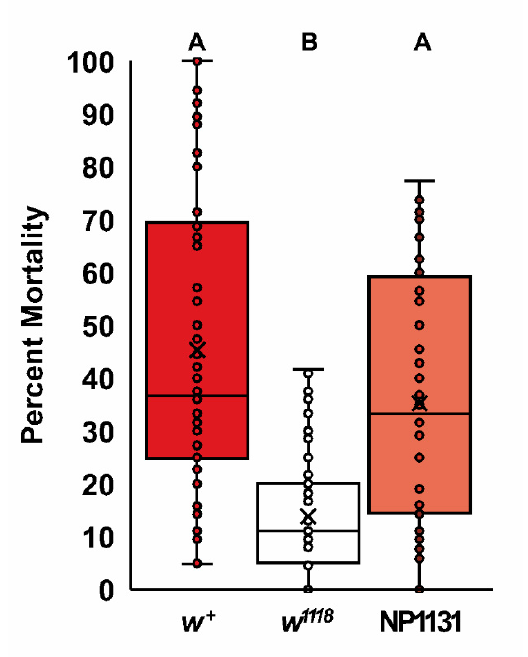
Figure 5. The w 1118 mutants have increased freeze tolerance. Wildtype Canton-S ( w + ), w 1118 , and w 1118 ; NP1131(mini- white ) genotypes were subjected to 120 min at − 5 °C, followed by a 24 h recovery at 25 °C. The median percentage of mortality after this recover period is shown as the center line, with the mean indicated by the x. There were significant differences in mortality between genotypes (Kruskal–Wallis, k = 73.404, p < 0.0001, n = 64–68). The w 1118 flies survived the subfreezing temperature significantly better than w + and w 1118 ; NP1131 (Dunn’s procedure, p < 0.0001; n = 64–68). Groups that do not share letters above the box plots are significantly different from each other according to the Dunn’s post hoc test ( p < 0.05).